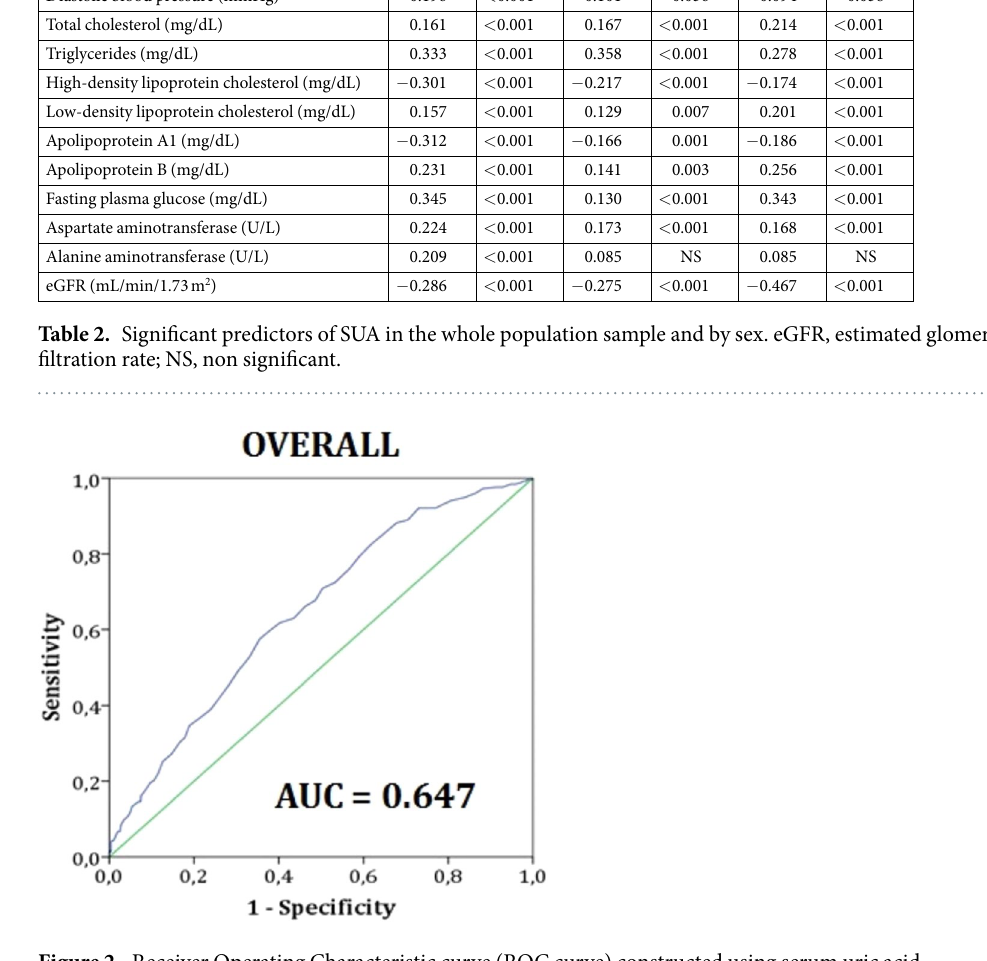
Figure 2. Receiver Operating Characteristic curve (ROC curve) constructed using serum uric acid concentrations (mg/dl) as test variable and metabolic syndrome as state variable in the general population. Data refer to the 2008’s population